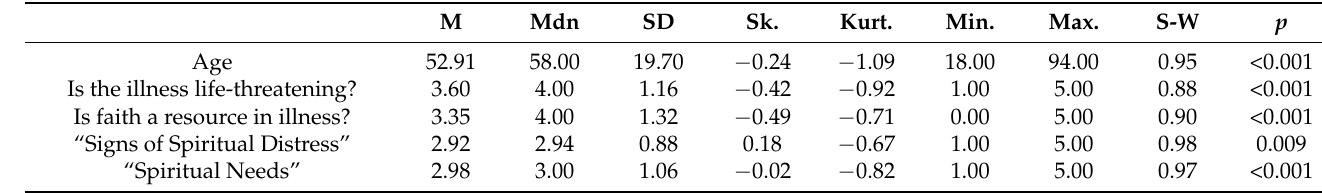
Table 3. Descriptive statistics with testing of the normality of